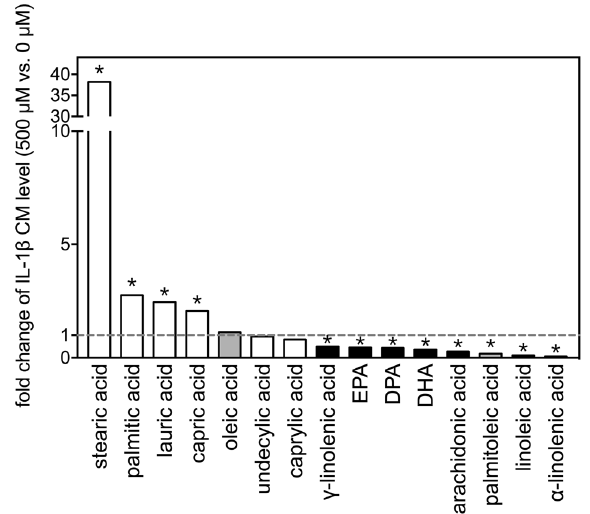
Figure 4. Fold-changes of IL-1β levels after treatment with selected fatty acids. Fold changes in levels of IL-1β in the conditioned media between 500 µM and 0 µM (vehicle control) of the 15 FAs after incubation with THP-1 cells for 24 h. The asterisks indicate significance in post-hoc comparison (500 µM vs. 0 µM) shown in Fig.